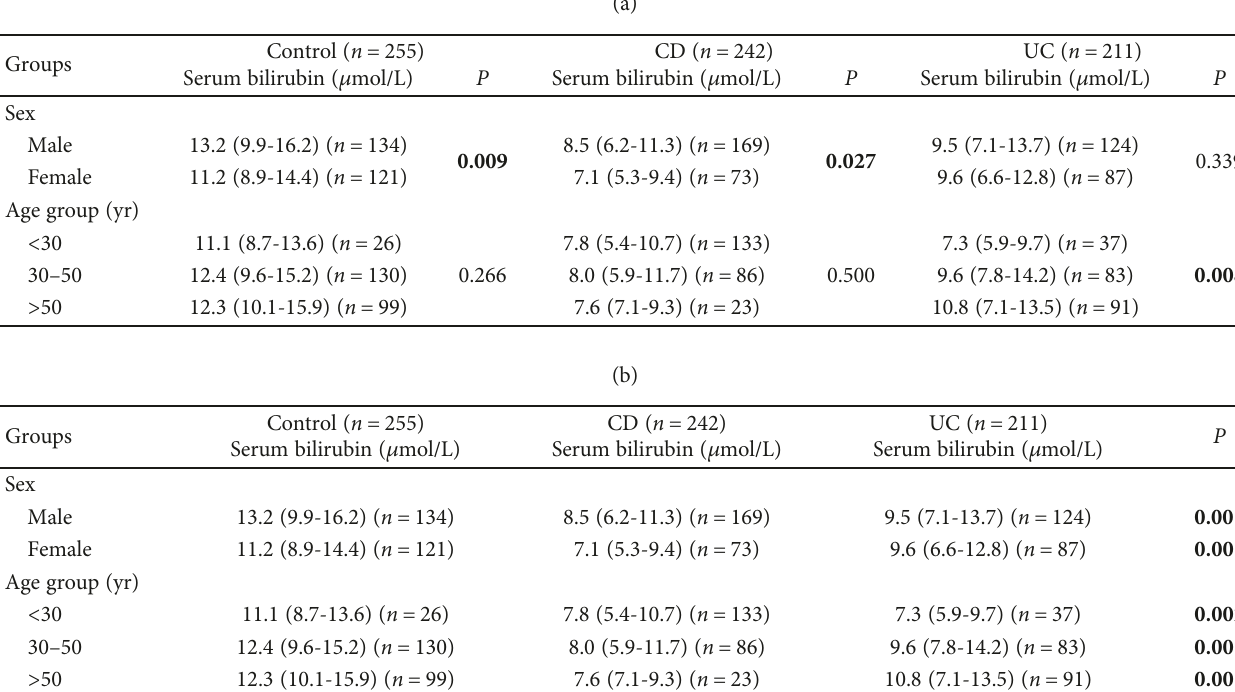
Table 2: Serum total bilirubin (sTB) levels in patients with IBD.